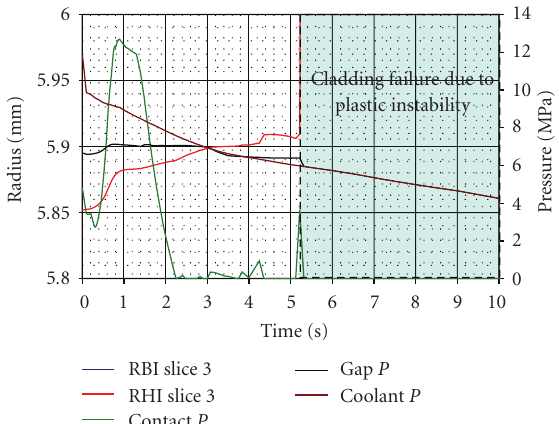
Figure 11: Equivalent and burst stress and creep strain as a function of time, Rod 267 BL21 slice